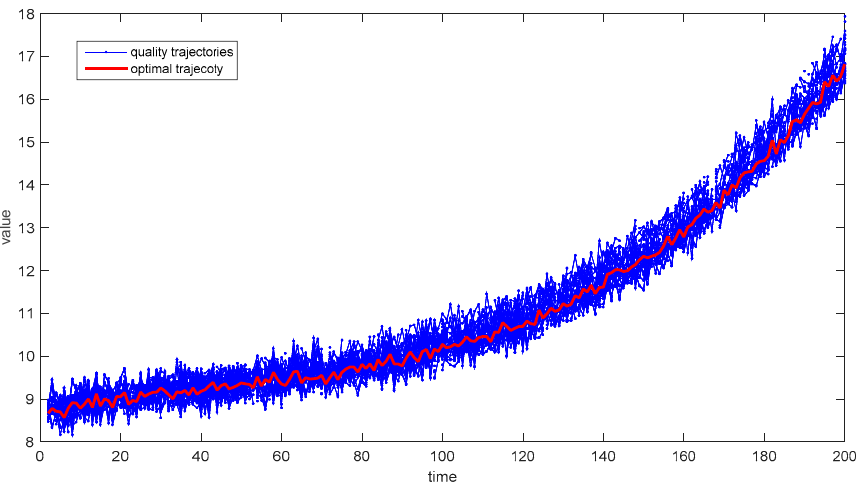
Table 2. Parameter values of different output modes in numerical example. a